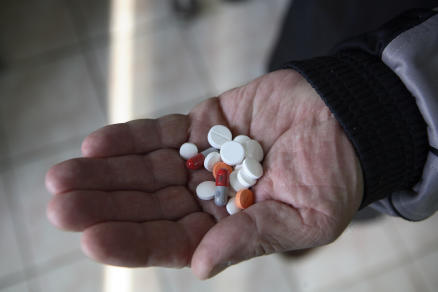
A Patient with MDR-TB Holds the Dose of Drugs He Must Take Every DayThis patient checked into the hospital in November 2006 and in January 2007 he tested negative; if his progress continues, he could be sent home to finish his treatment. (Photo: Jean-Marc Giboux)